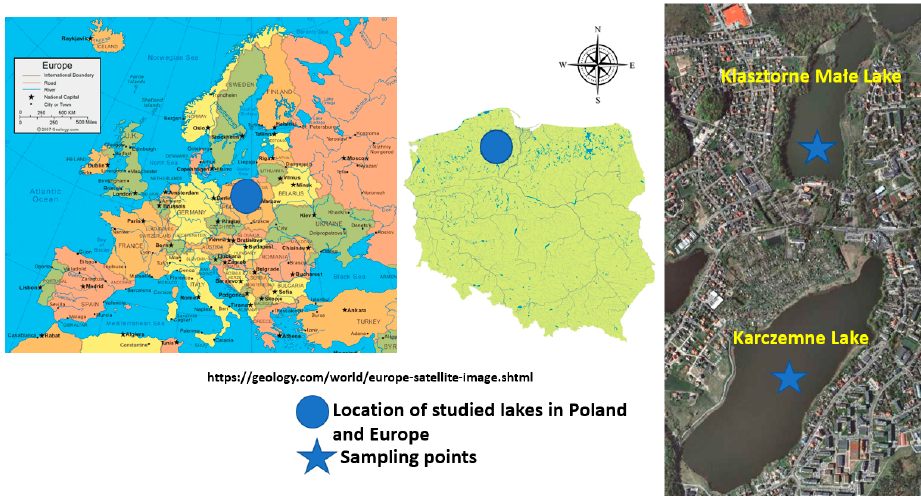
Figure 1. Research area location of Karczemne and Klasztorne Ma ł e lakes.